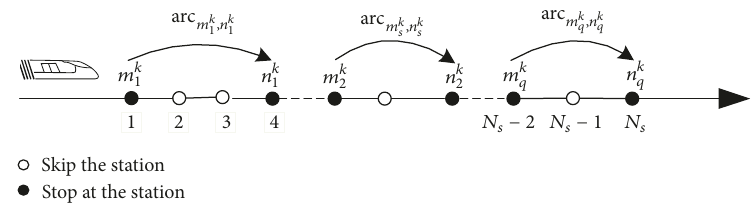
Figure 4: Definition of 𝑆 𝑘 and “skip